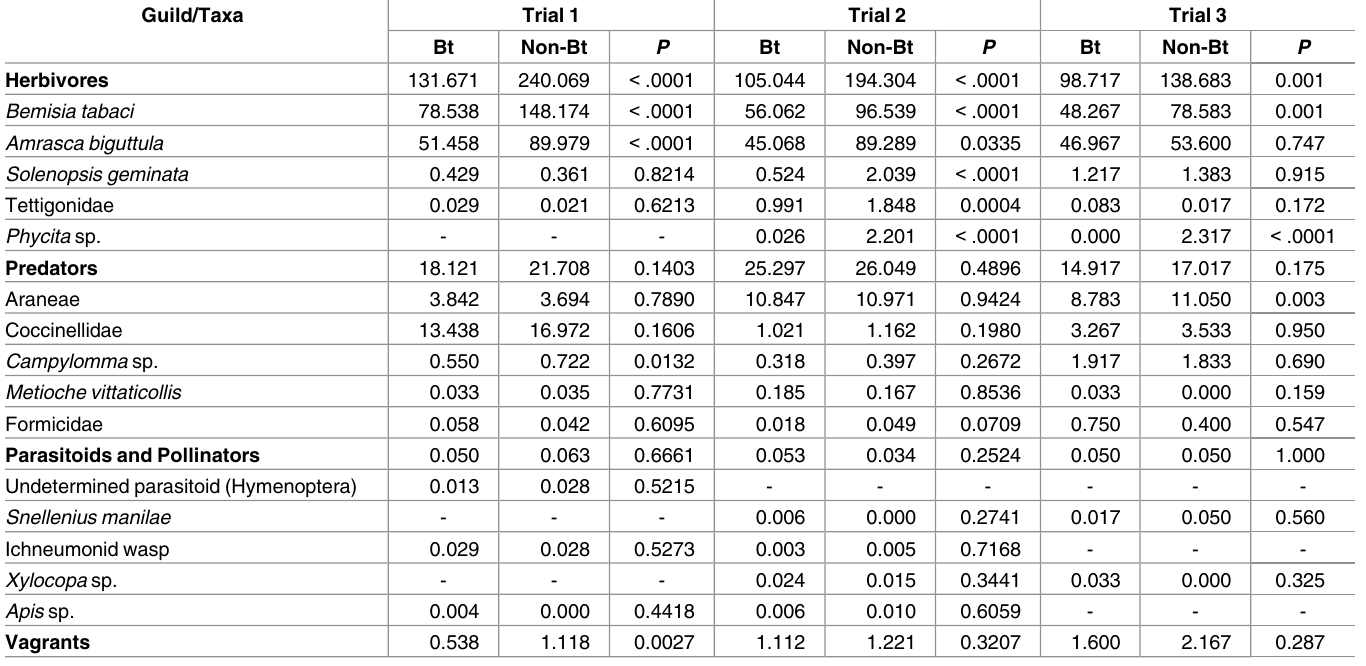
Table 2. Mean comparison of NTA abundance among functional guilds and taxa in Bt and non-Bt